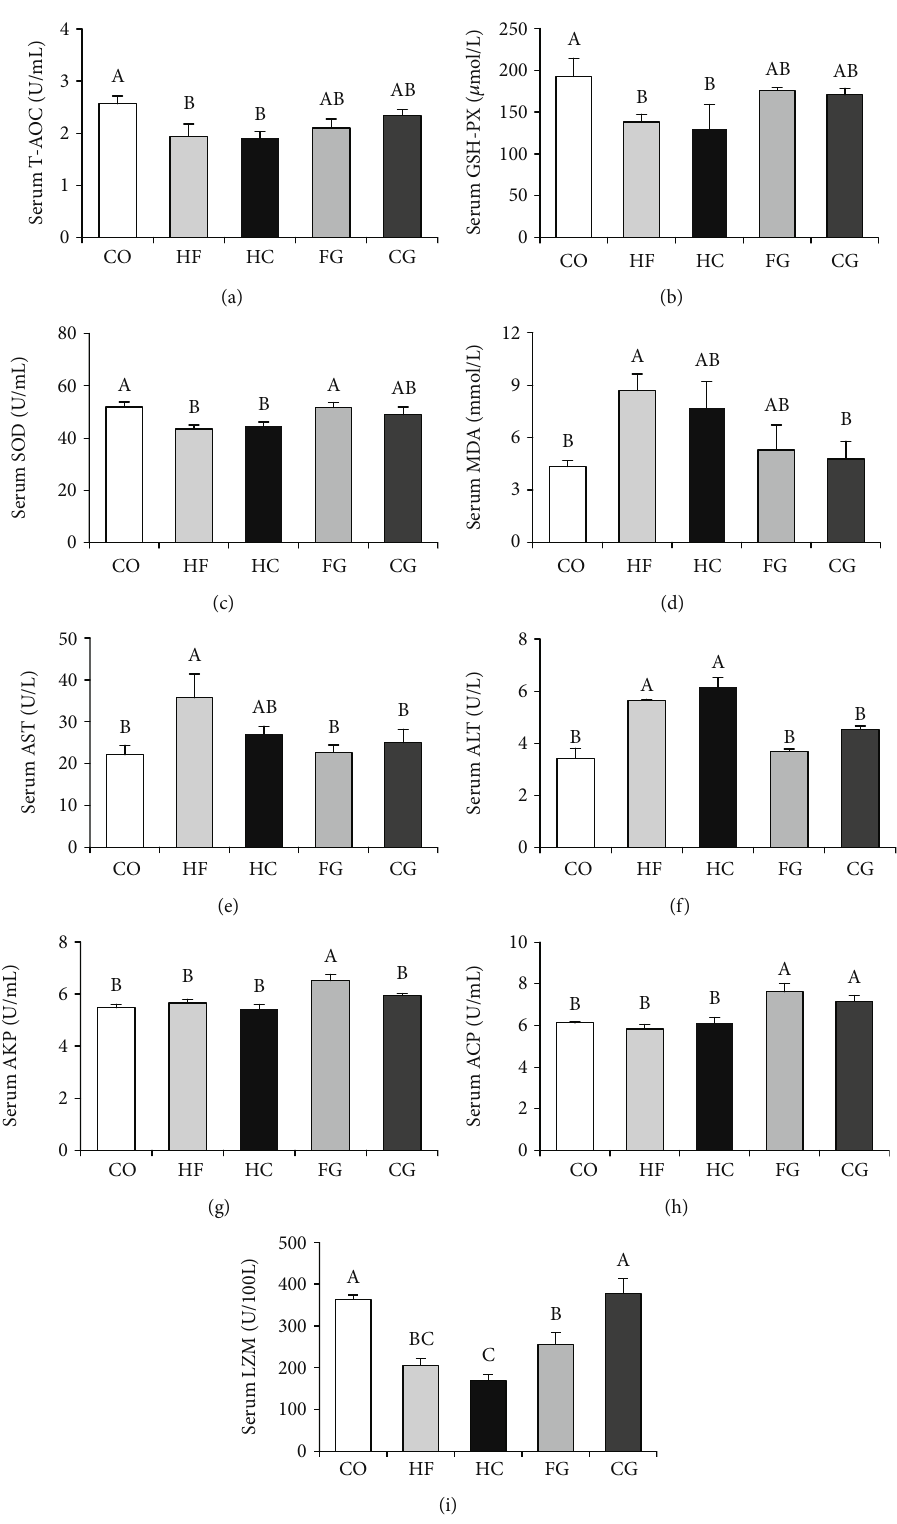
Figure 2: Serum antioxidant and immune enzyme activity parameters of common carp fed di ff erent experimental diets: (a) total antioxidant capacity (T-AOC); (b) glutathione peroxidase (GSH-PX); (c) superoxide dismutase (SOD); (d) malondialdehyde (MDA); (e) aspartate aminotransferase (AST); (f) alanine aminotransferase (ALT); (g) alkaline phosphatase (AKP); (h) acid phosphatase (ACP); (i) lysozyme (LZM). Values are means ± S : E : per diet in triplicate tanks ( n = 6 ). The di ff erent letters indicate the di ff erences between diets (one-way ANOVA, Duncan ’ s test, P < 0 : 05